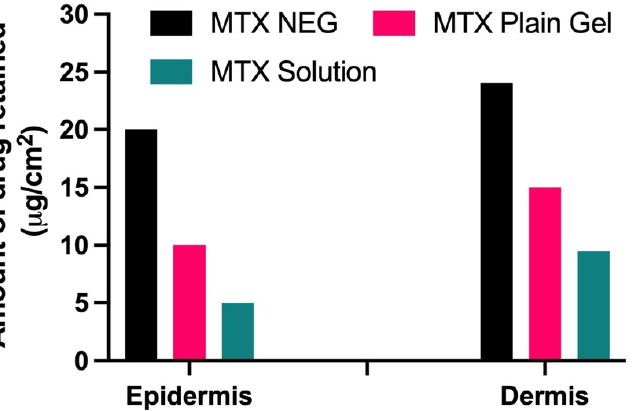
Figure 5. Amount of drug retained ( μ g/cm 2 ) in epidermis and dermis layers of the skin ( p < 0.01 vs. MTX plain gel and MTX